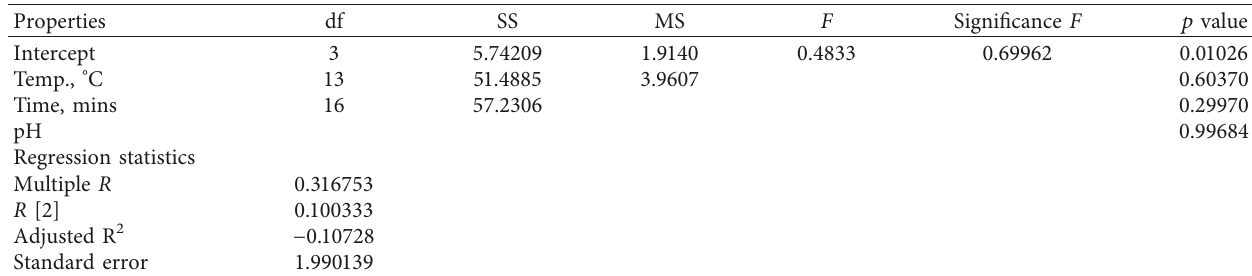
Table 3: ANOVA for dyeing